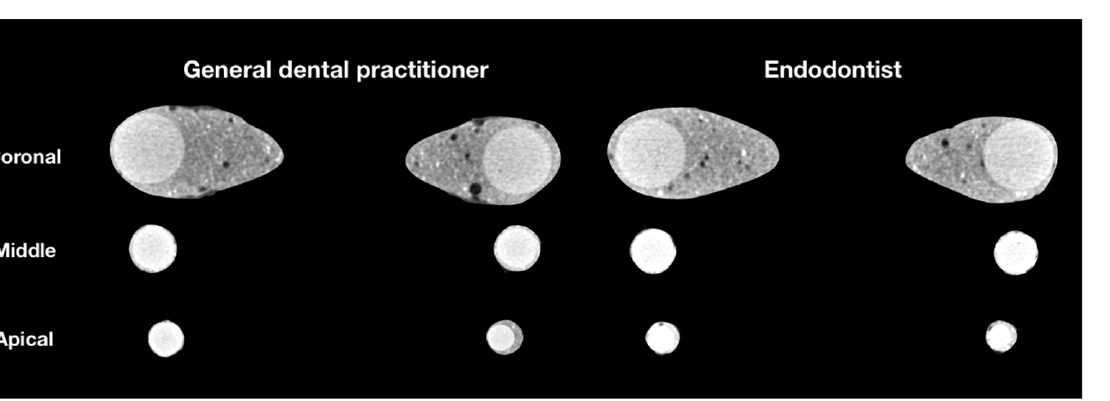
Figure 1. Representative cross-sectional 2D images at the coronal, middle and apical thirds of random samples of GDP and ED groups, demonstrating the porosity distribution of the fillings.